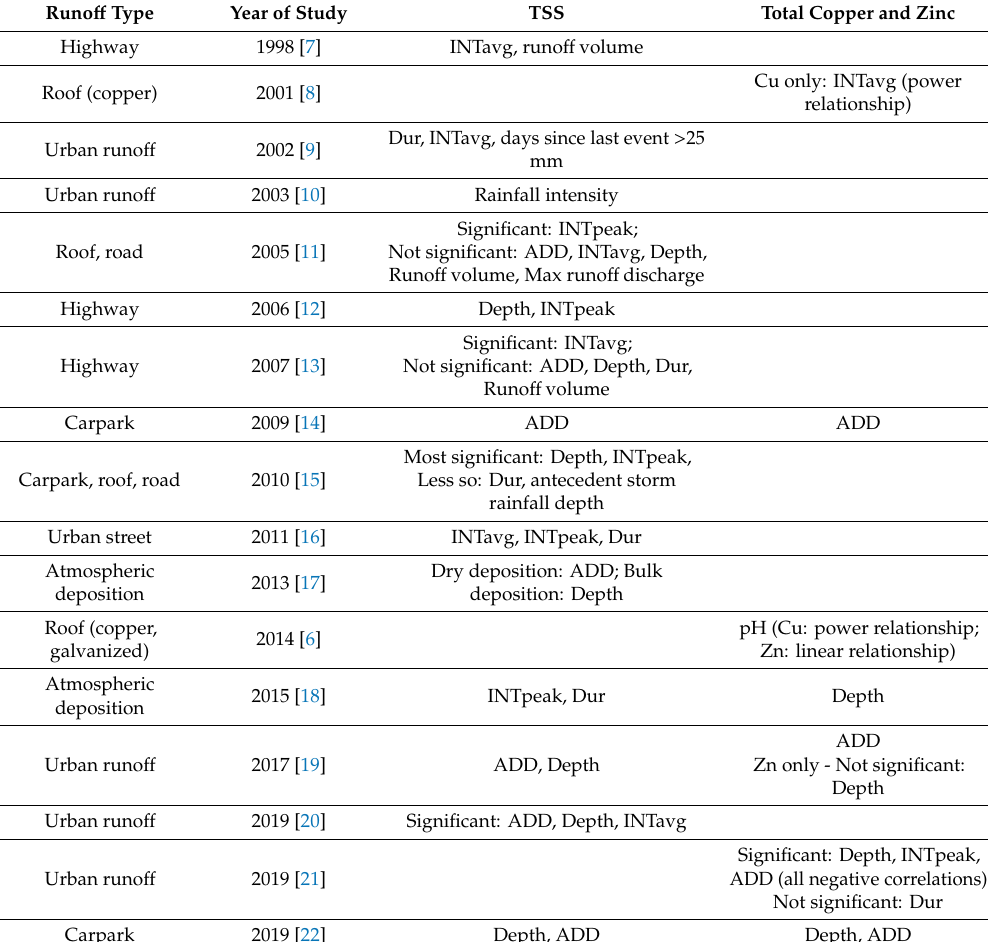
Table 1. Reported relationships between pollutants in untreated runo ff and rainfall characteristics (chronological